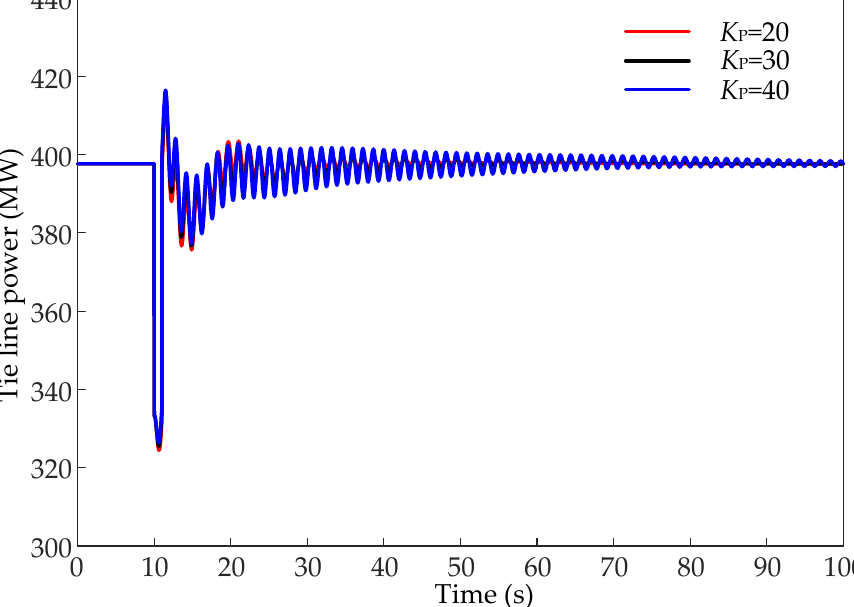
Figure 7. The response curves of tie-line power with different values of the gain K P ( K D = 40). It can be seen from Figure 6 that when K P = 20, the oscillation of tie-line power de- creases with the increase of K D , which indicates that the increase of K D is conducive to inter-area oscillation suppression. It can be seen from Figure 7 that when K D = 40, with the increase of K P , the oscillation of tie-line power increases. It shows that the inter-area oscil- lation increases with the increase of K P . The time domain simulation results are consistent with the modal analysis results.